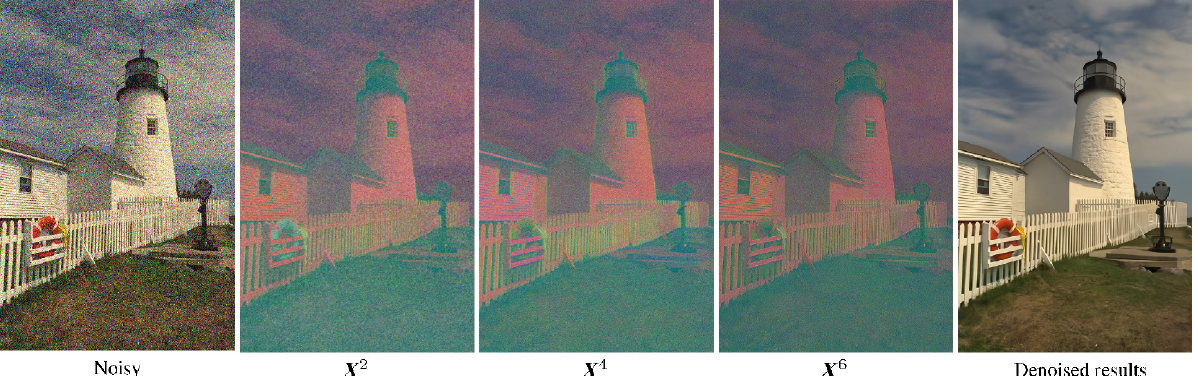
Fig. 9 Visualizations of intermediate features in